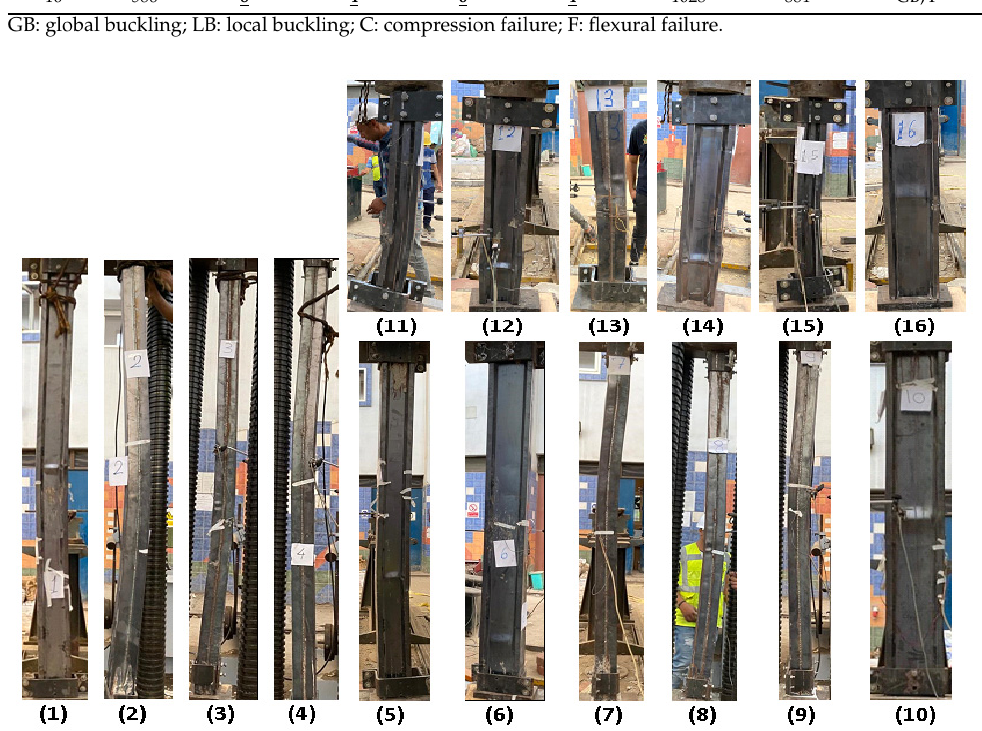
Table 5. Summary of experimental program results.